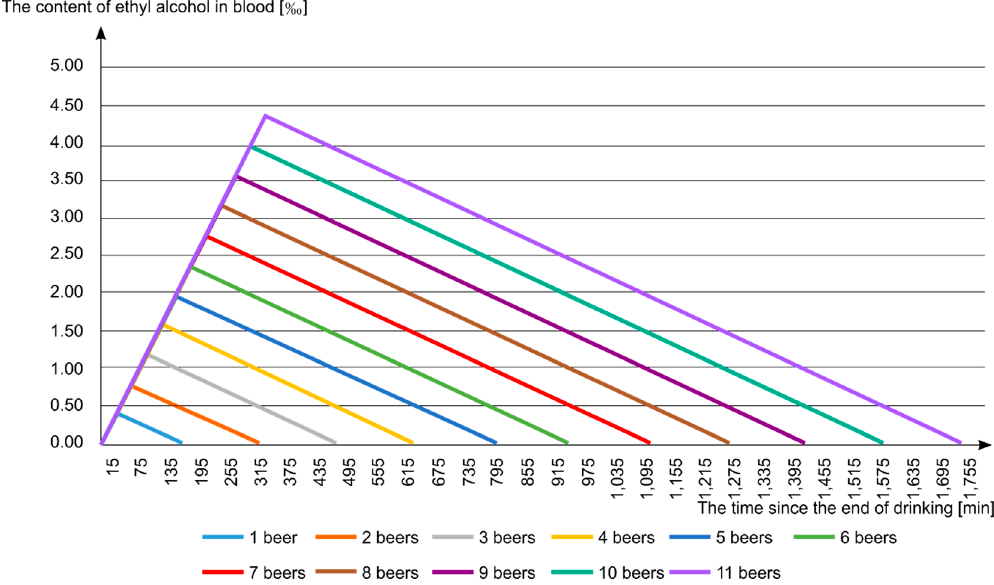
Figure 3. The content of ethyl alcohol in the blood with regards to the dose of alcohol consumed (from 1 beer to 11 beers) and the time since the end of drinking (own elaboration). Table 1. Collective summary of the content of ethyl alcohol in the blood with regards to the dose of consumed alcohol (from 1 beer to 11 beers) and the time since the end of drinking (own elaboration). Content of Alcohol Dose Content of Ethyl Alcohol in Blood Blood Alcohol Concentration (BAC) Time Since the End of Drinking Alcohol dose Ethyl Alcohol Number of in Blood 4.5% Beers /